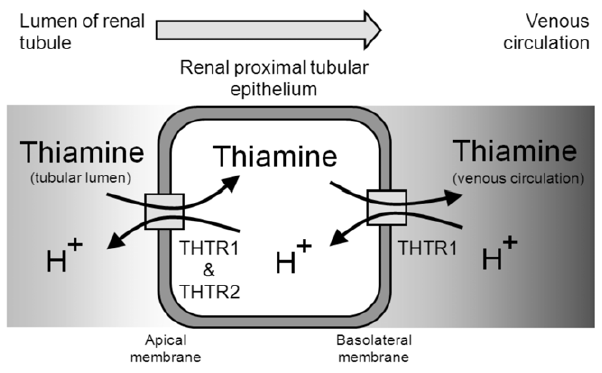
Figure 4. Schematic diagram of thiamine transpermeability across the proximal tubular